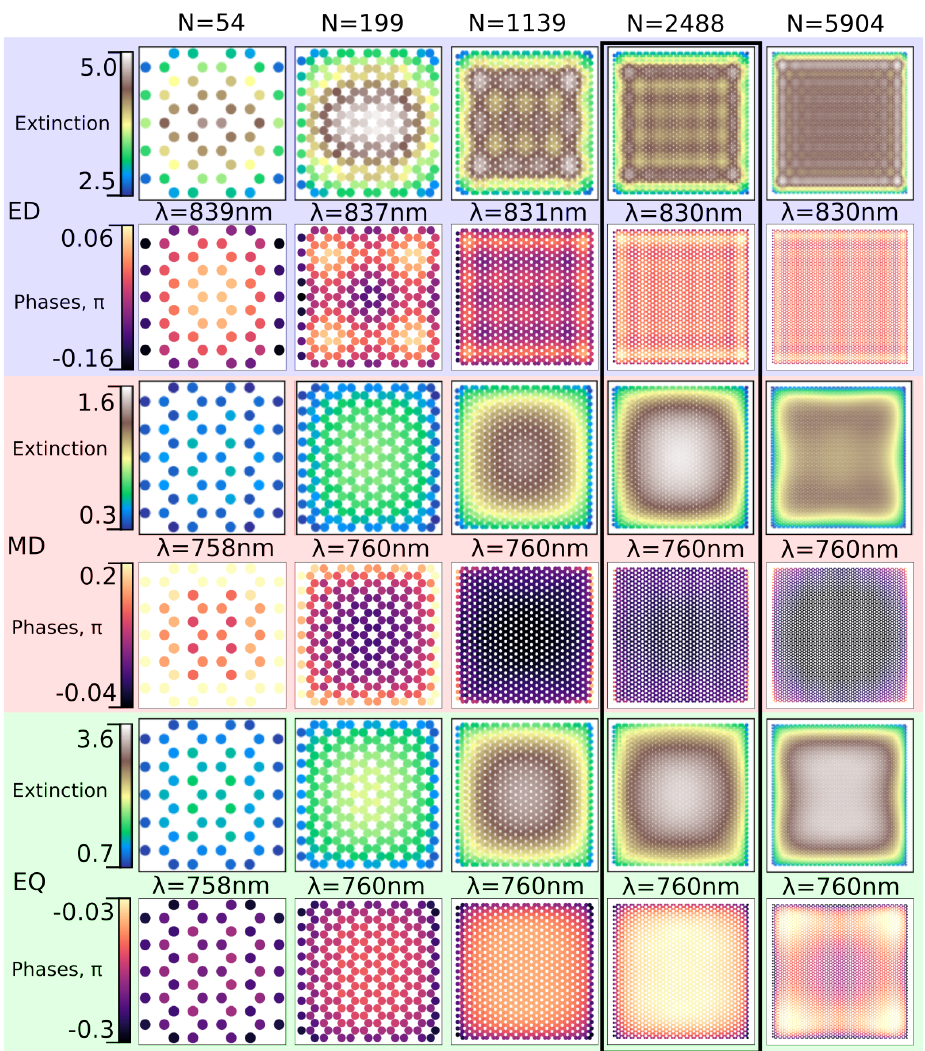
Figure 5. Evolution of the extinction efficiency per NP and scattered wave phases for different N for ED, MD, and EQ resonances. Highlighted N = 2488 case corresponds to data shown in Figure